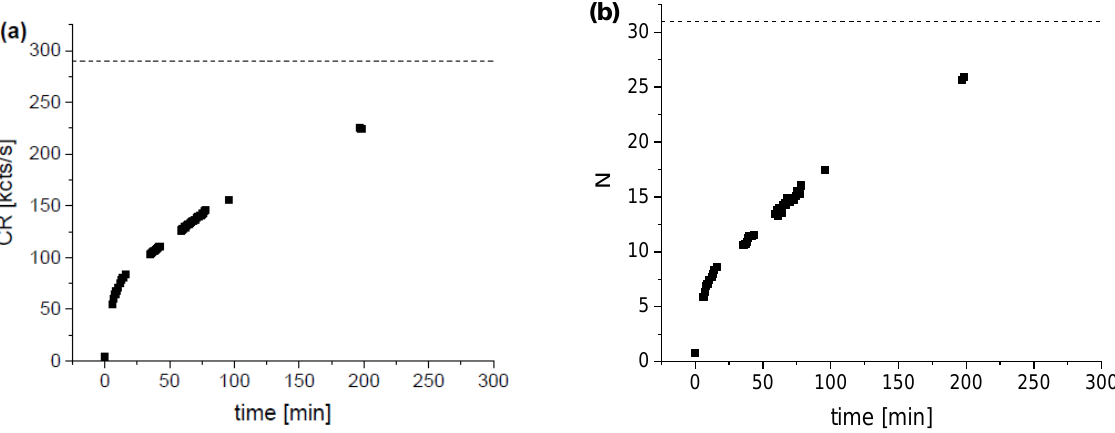
Figure 1. Plot of the time dependence of CR ( a ) and N ( b ) for the DAF-2 (250 nM) + GSNO (70 µ M) solution in PBS. The dashed lines in ( a ) and ( b ) indicate the expected limits corresponding to c m = 250 nM.